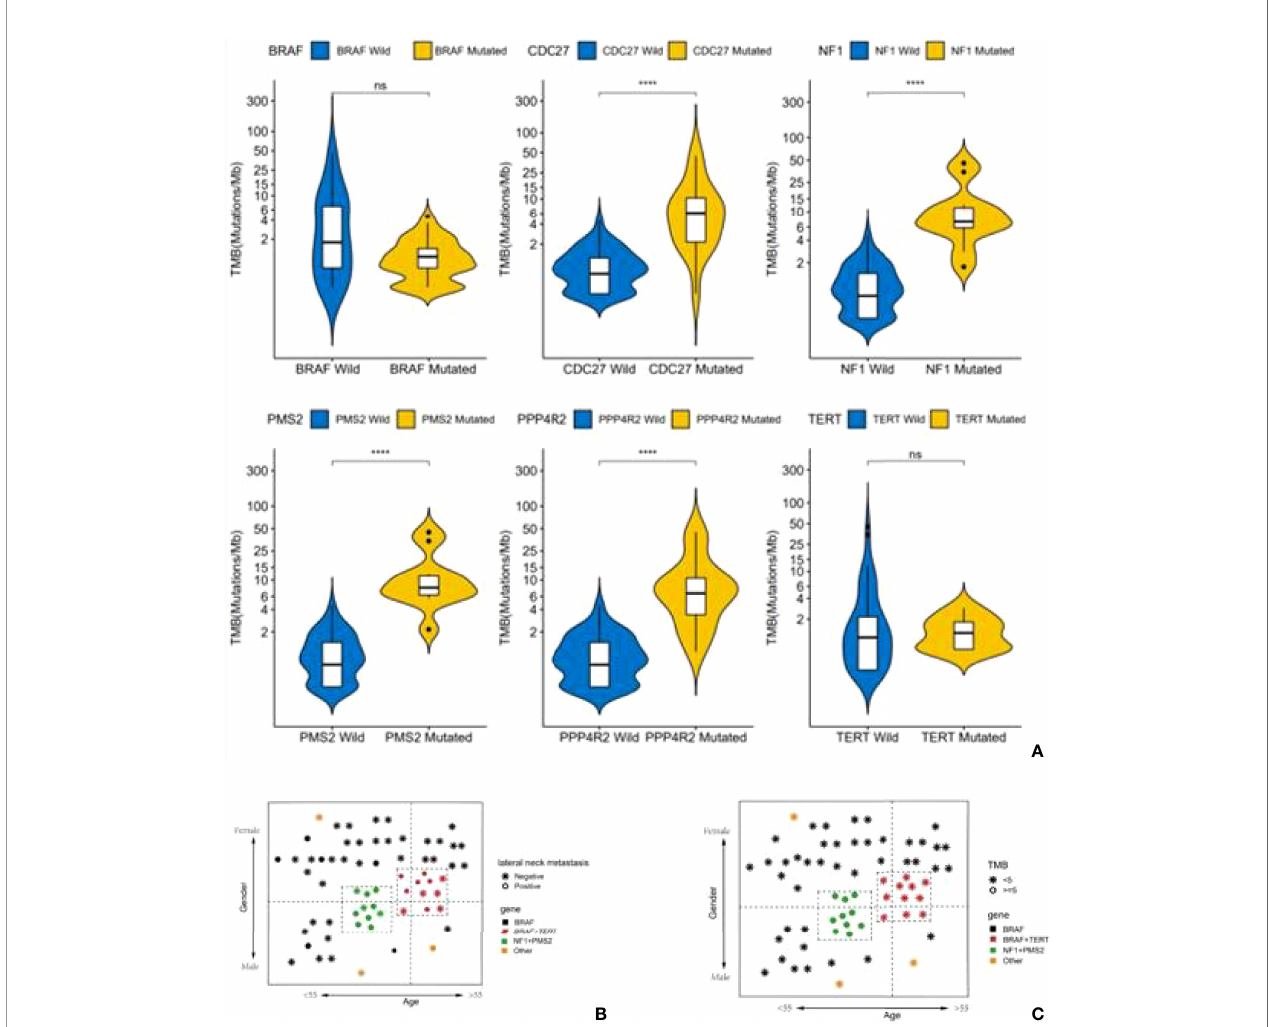
FIGURE 6 | A high tumor mutational burden (TMB) in patients with mutations of NF1, PMS2, CDC27 or PPP4R2. Patients with lateral cervical lymph node metastasis were more common in both the BRAF-TERT mutation group and the NF1-PMS2 group. (A) Difference of TMB level between single gene mutant and wild type (ns,no signi fi cance,****: P <0.001). (B) Status of lateral cervical lymph nodes in people patients with different gene mutations. (C) The level of TMB in patients with different gene